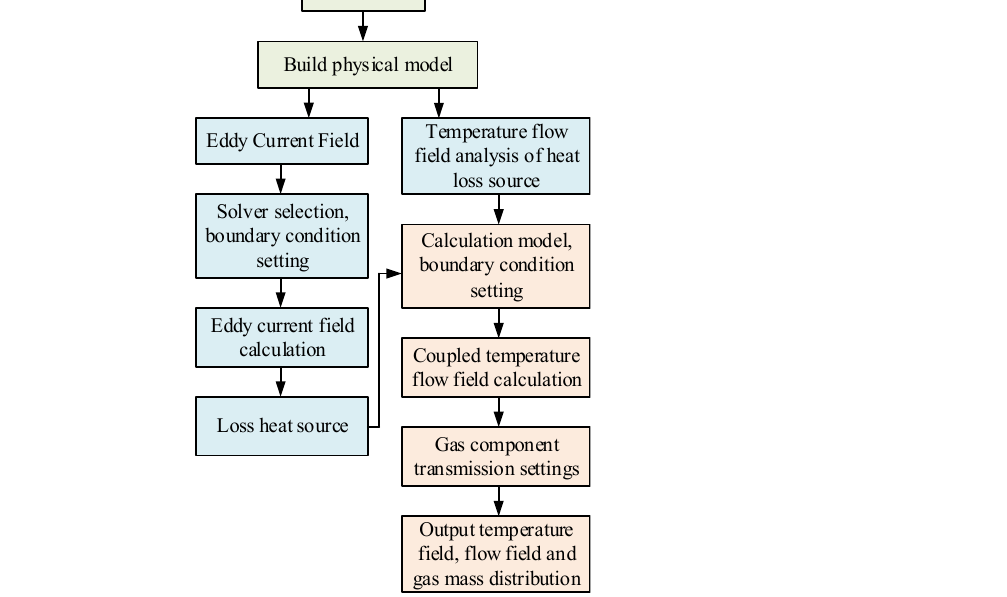
Figure 3. Flow chart of the indirect coupling calculation of the multi-physical fields.